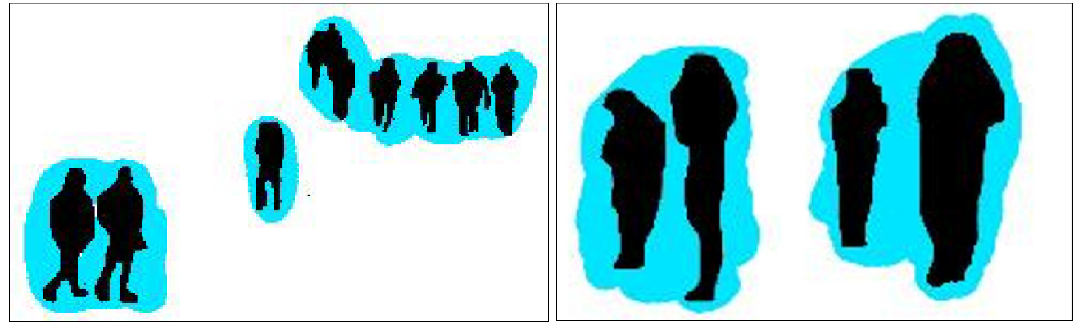
Figure 6. Results of Gaussian clustering over-extracted human silhouettes.